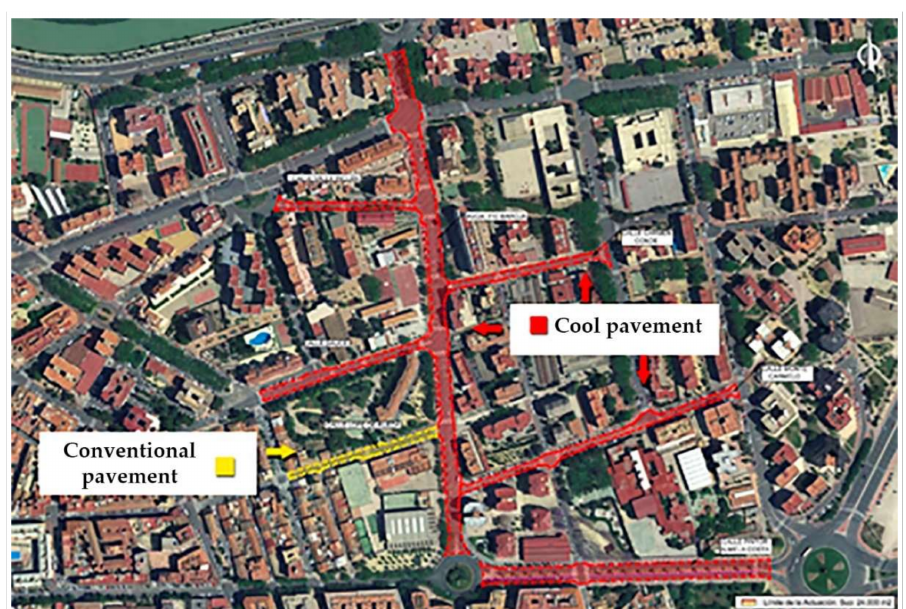
Figure 1. Location of new pavement—city of Murcia (Spain). Tower no. 1, installed on the streetlight identified as number 21, located at the intersection of Pio Baroja and San Juan de la Cruz Avenues. Tower no. 2 is installed on streetlight number 14, located in Pio Baroja Avenue in front of Lope de Rueda Street. Tower no. 3 is installed together with streetlight number 8, in Lope de Rueda Street. Tower no. 4 is installed on the streetlight which is within the roundabout where los Dolores Avenue, Ronda Sur Avenue, Pintor Pedro Almela Costa Street and Vicente Aleixandre Street